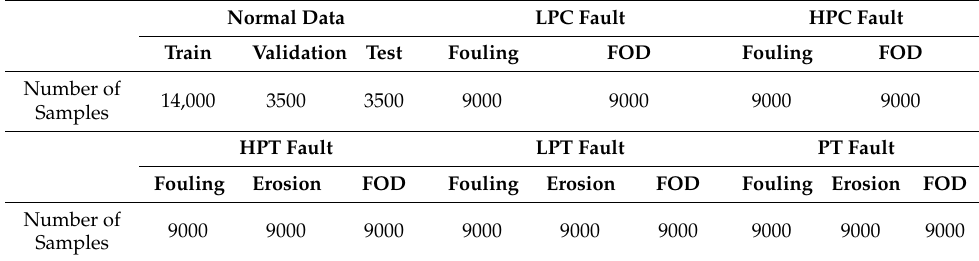
Table 2. Dataset